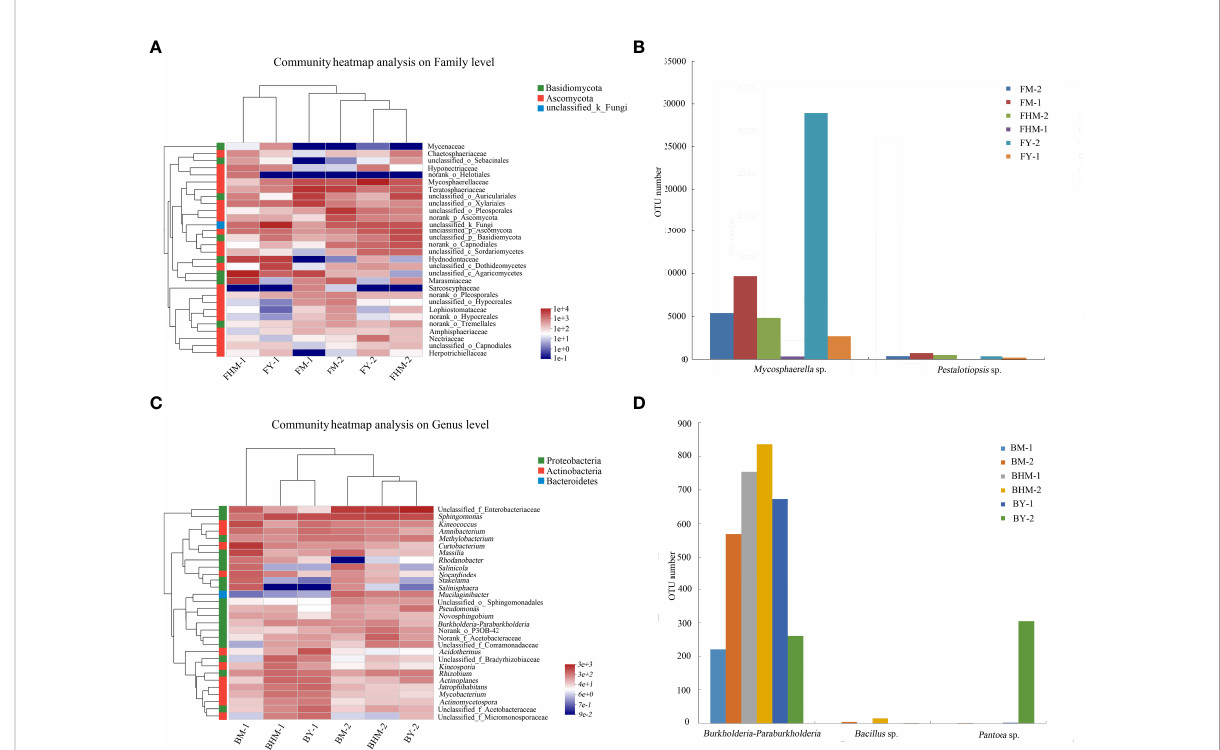
FIGURE 6 Heatmap showing the dominant fungi and bacteria at the genus level in the litter of different plantation ages of C. equisetifolia . (A) community heatmap of fungi on family level; (B) OTU numbers of Mycosphaerella sp. and Pestalotiopsis sp.; (C) community heatmap of bacteria on genus